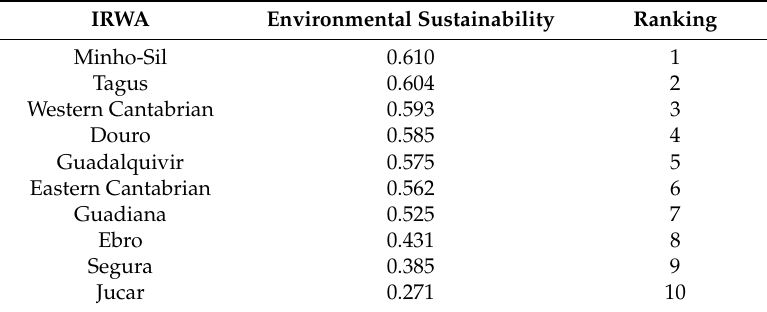
Table 7. Environmental sustainability of